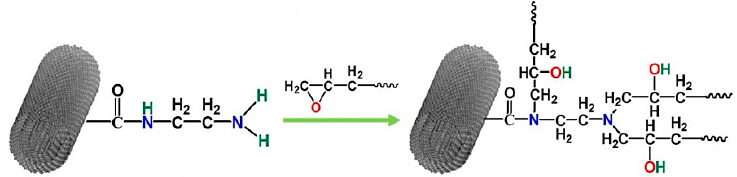
Figure 2. Reaction mechanism of surface sizing treated multi-walled carbon nanotubes (MWCNTs).